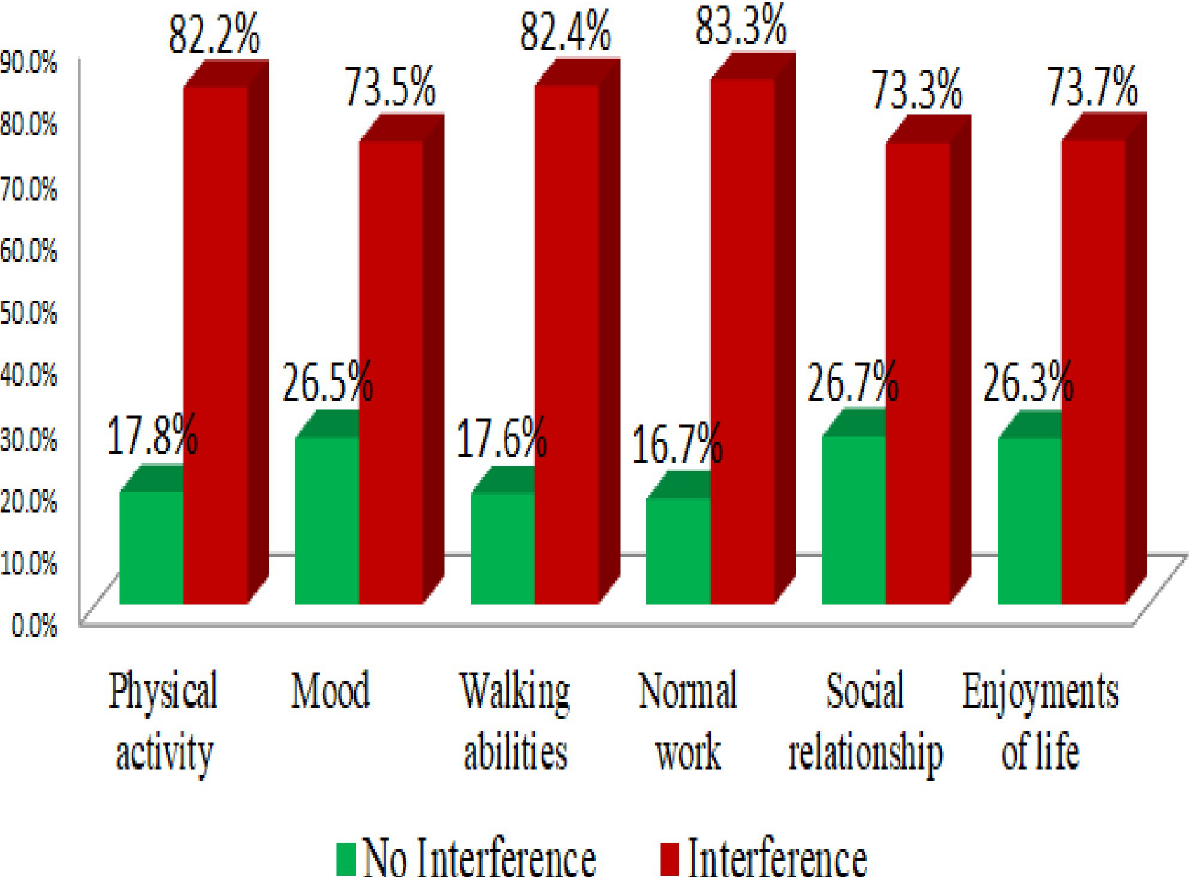
Fig 4. Interference of fatigue on daily activities among adult cancer patients receiving cancer treatment at oncology unit in Amhara region, Ethiopia, 2022 (N = 449).